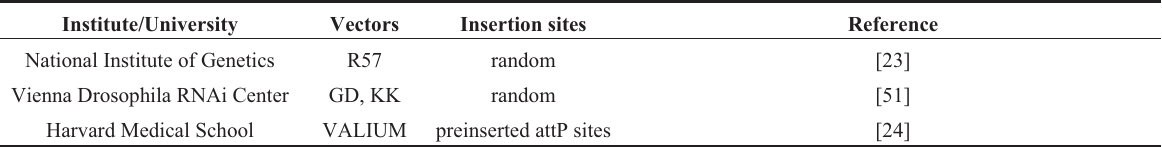
Table 1. Drosophila RNA interference (RNAi)